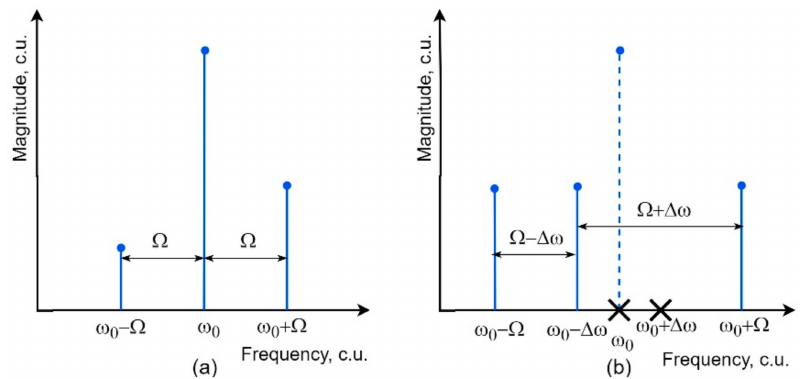
Figure 5. Spectra of scanning optical double-sideband (ODSB)-signals: ( a ) With symmetric ODSB, ( b ) with asymmetric ODSB. ω 0 —the frequency of optical carrier; Ω —the modulation frequency; ∆ ω —a fixed frequency shift.